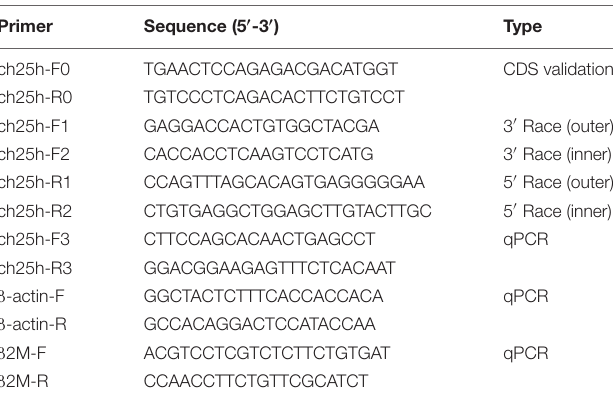
TABLE 3 | Sequences of the primers used in this